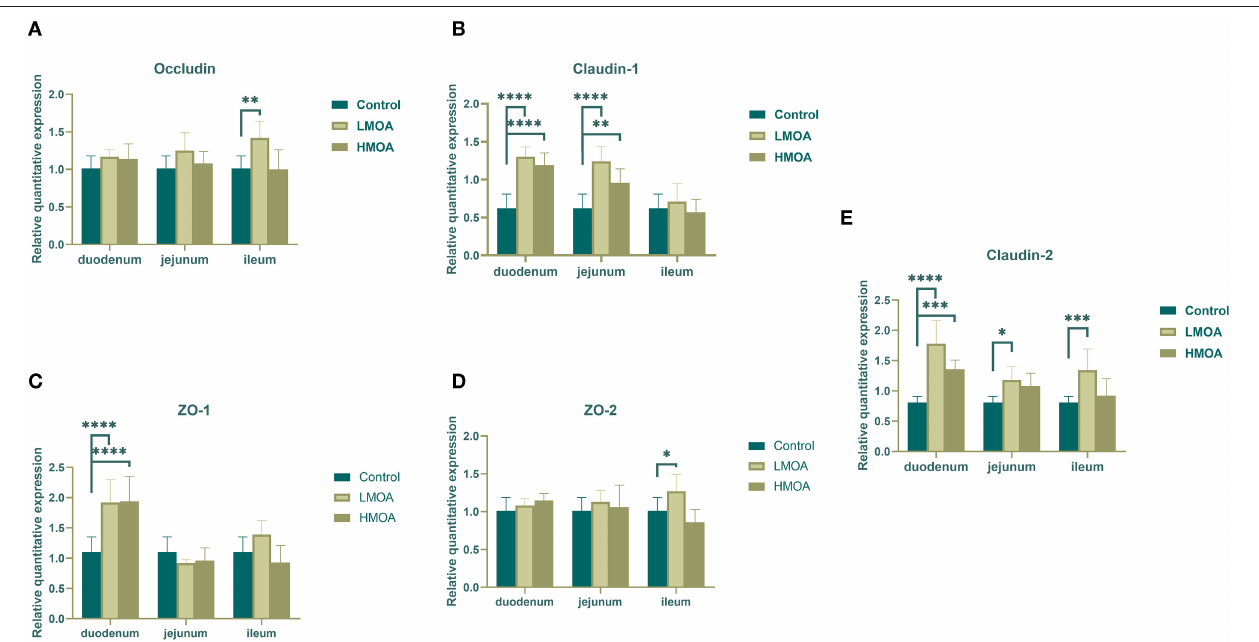
FIGURE 4 | The gene expression of tight junction protein in duodenum, jejunum and ileum of 42 d-broilers as affected by dietary MOA supplementation. (A) Occludin, (B) Claudin-1, (C) ZO-1, and (D) ZO-2, (E) Claudin-2. Control: a basal diet of corn-soybean meal with 0 mg/kg of mixed organic acid; LMOA: a basal diet with 3,000 mg/kg of mixed organic acids; HMOA: a basal diet with 6,000 mg/kg of mixed organic acids. Data are indicated as means ± SEM ( n = 8). Bar with the asterisk (*) level presented the degree of significant difference. * 0.01 < p < 0.05; ** 0.001 < p < 0.01; *** 0.0001 < p < 0.001; **** p <